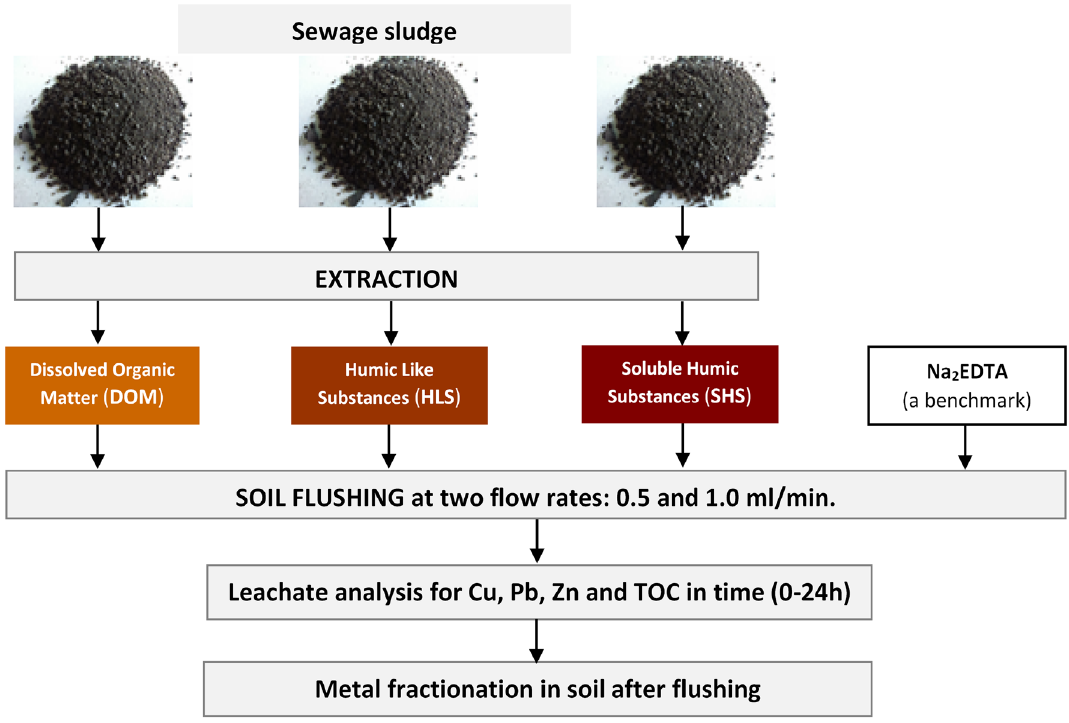
Figure 2. Research scheme on soil flushing with